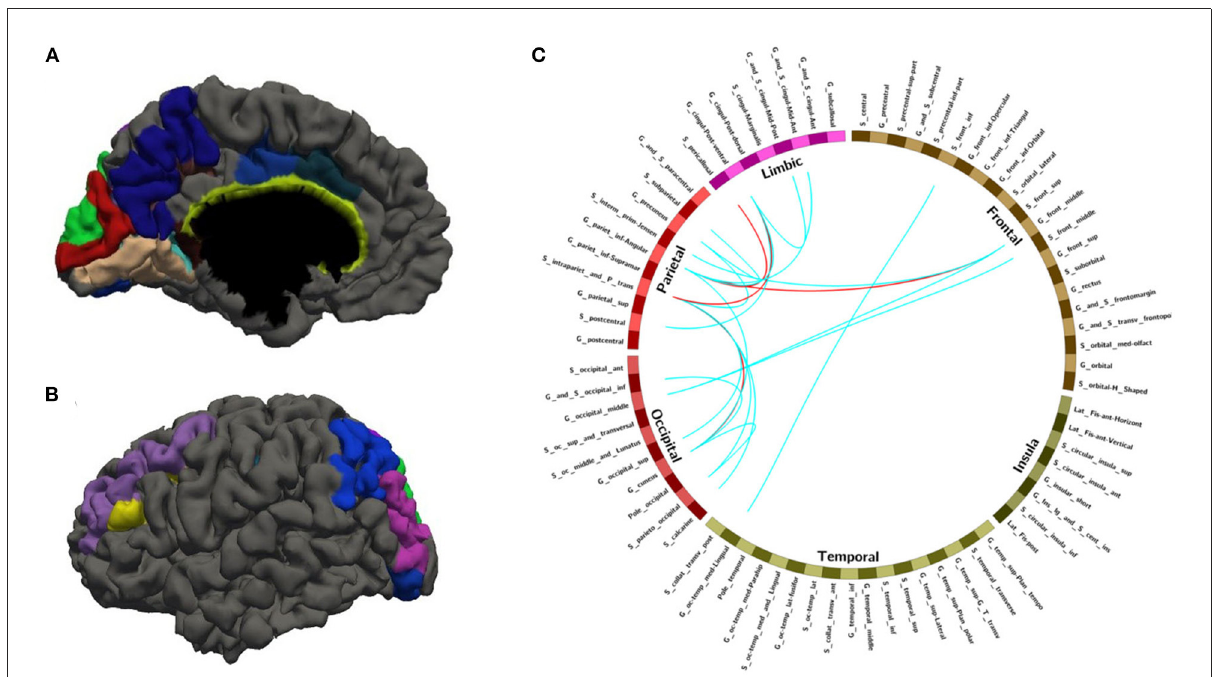
FIGURE4 The nodes and edges involved in the FC features with a high overlap rate (12/14) among training with random sample selection. (A,B) Regions involved in 28 FC features with overlapping ratios ≥ 12/14 across 14 training sessions. (C) Edges involved in 28 FC features with overlap ratio ≥ 12/14 in 14 training